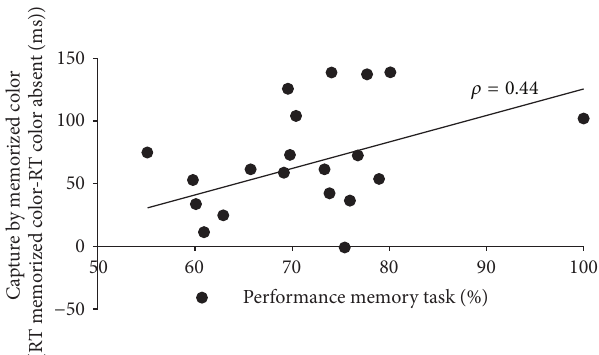
Figure 3: Scatter plot showing the bivariate correlation between the capture by memorized colors and the performance in the memory task. Capture is defined by the RT increase in trials with distractors with memorized colors compared to trials with no colored distractor. Each black circle represents one participant. The pattern of results shows that participants that were good in memorizing colors in the working memory task were more likely distracted by memorized colors in the search